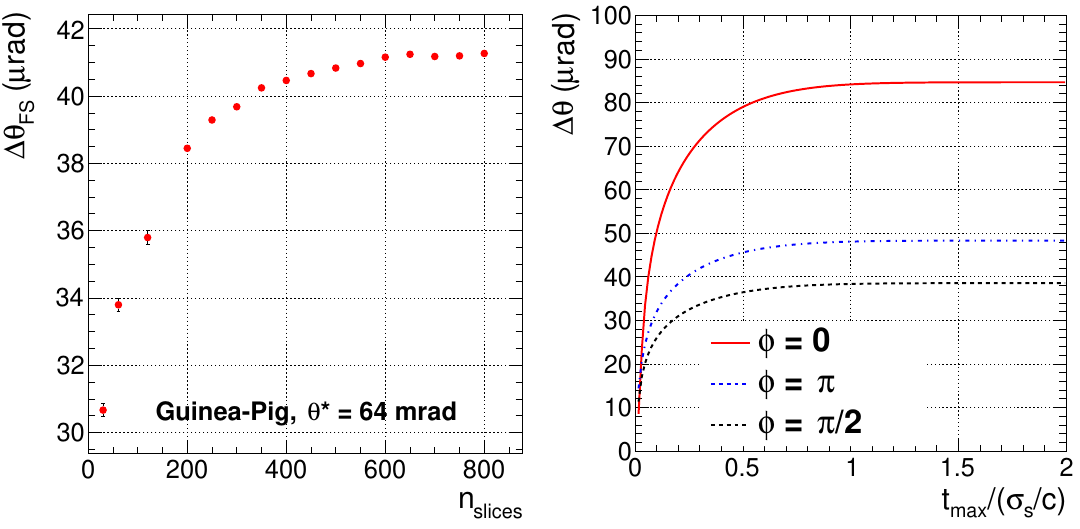
Figure 8 . Left: Average de(cid:13)ection angle as predicted by Guinea-Pig as a function of the number of longitudinal slices of the bunch. Right: De(cid:13)ection angle of an electron with E = 45 : 6 GeV emerging at (cid:18) (cid:3) = 64 mrad from a Bhabha interaction taking place at the nominal interaction point and at t = 0, as a function of time, for three example values of the azimuthal angle of the